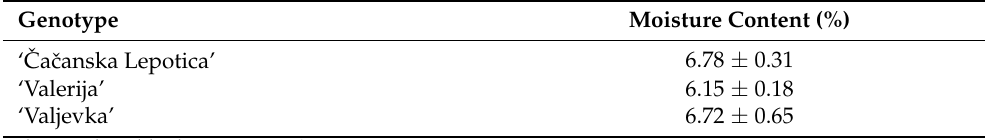
Table 1. Anthers moisture content measured immediately after